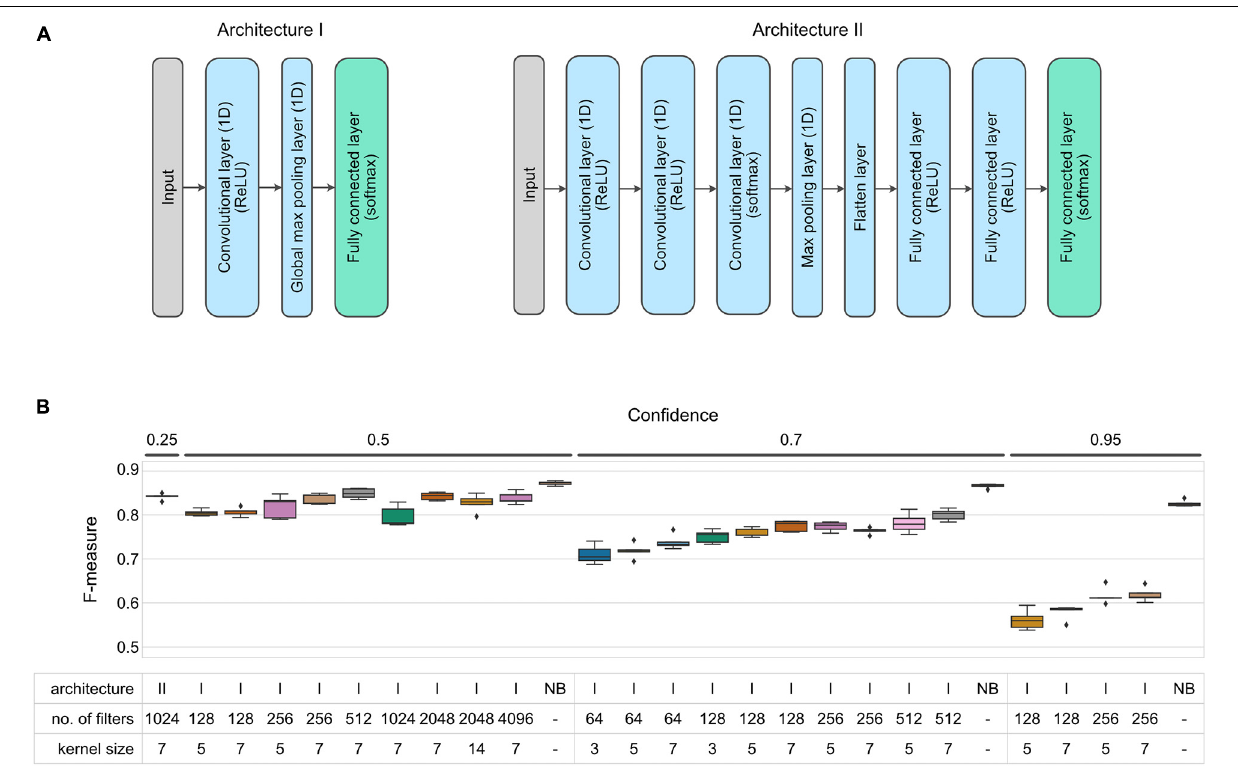
FIGURE 2 | F-measure accuracy performance of CNN and NB classifiers. (A) CNN architectures implemented in this benchmark. (B) Box-and-whisker plots indicate the median and quartile distributions of F-measures for each classifier and configuration, across 5-fold of CV. CNN classifier configurations were tested via a grid search across the hyperparameters listed in the subset table. NB classifiers do not have equivalent parameters, and hence only NB is listed in the table beneath bars representing NB classifiers. Both CNN and NB classifiers were tested at multiple confidence levels. None of the tested networks outperformed the NBC at a given confidence level (Wilcoxon test p <